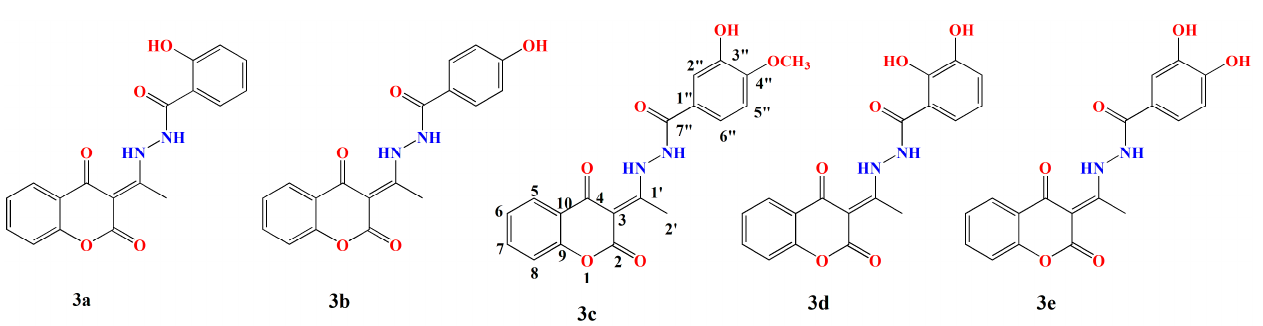
Figure 2. Structures of the investigated compounds ( 3a – 3e ).